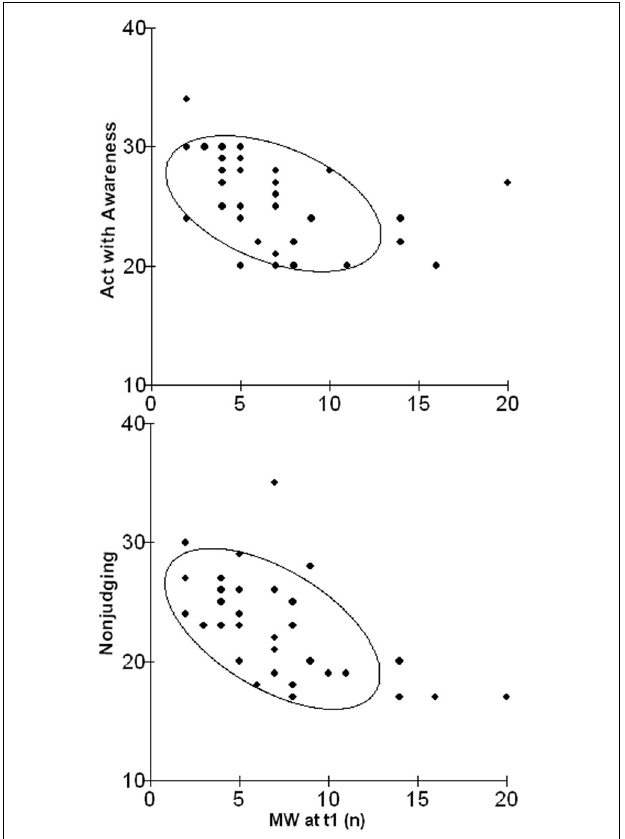
FIGURE 2 | Scatterplots illustrating the relationship between scores of the subscale Acting with Awareness (upper graph) and Non-judging (lower graph) of the FFMQ and the occurrence of episodes of MW in daily life after 1 year.